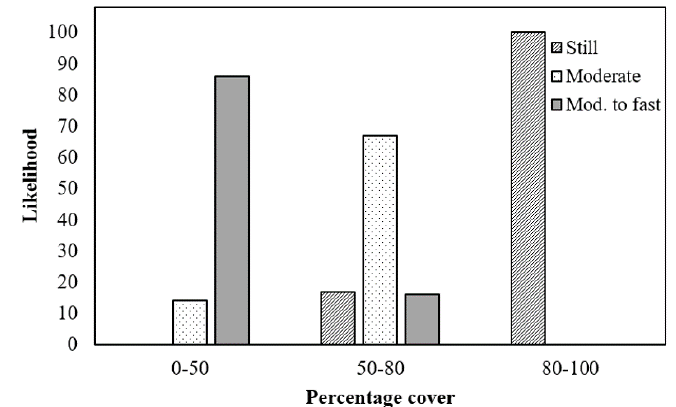
Figure 9: The association between the percentage cover of C . furcata population and the flow rate of the